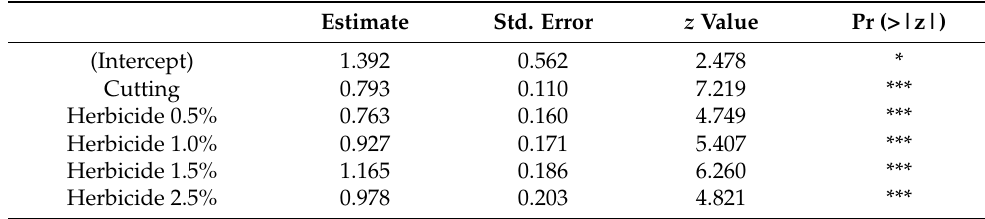
Table 3. Effect of treatments on the net demography of E. globulus wildlings as shown by a Generalised Linear Mixed Model. The table shows the coefficients of the model, the respective standard errors, the z statistic and the associated probabilities: ≤ 0.001 = ***; ≤ 0.05 =